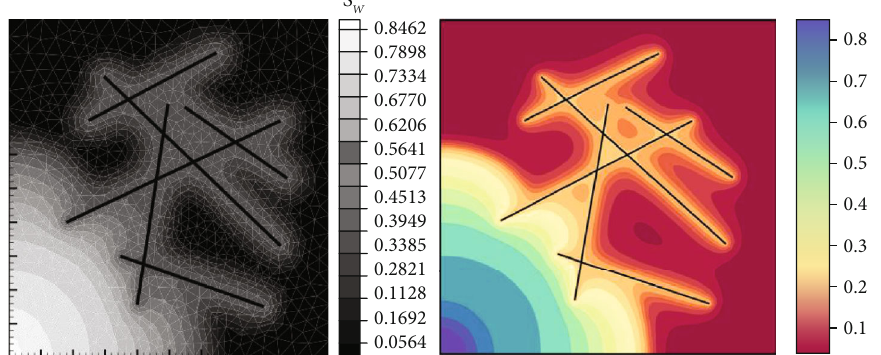
Figure 3: Distribution of water saturation after 25 days of water injection into a reservoir initially saturated with oil. Previous modeling results 22 and our simulation results are displayed on (a) and (b),